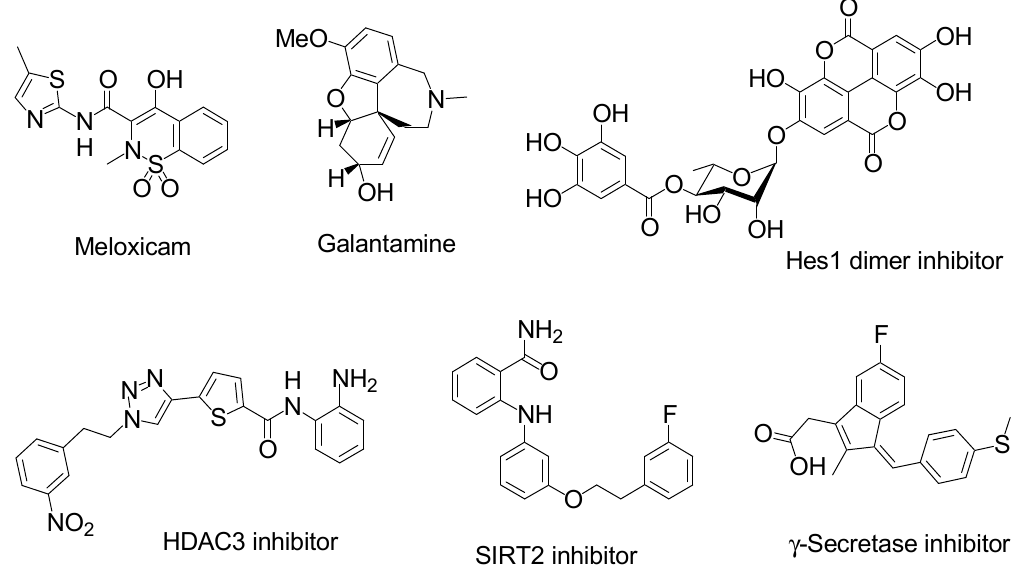
Figure 8. Structures of neurodegenerative disease modulators. HDAC stands for histone deacetylase. SIRT stands for sirtuin.